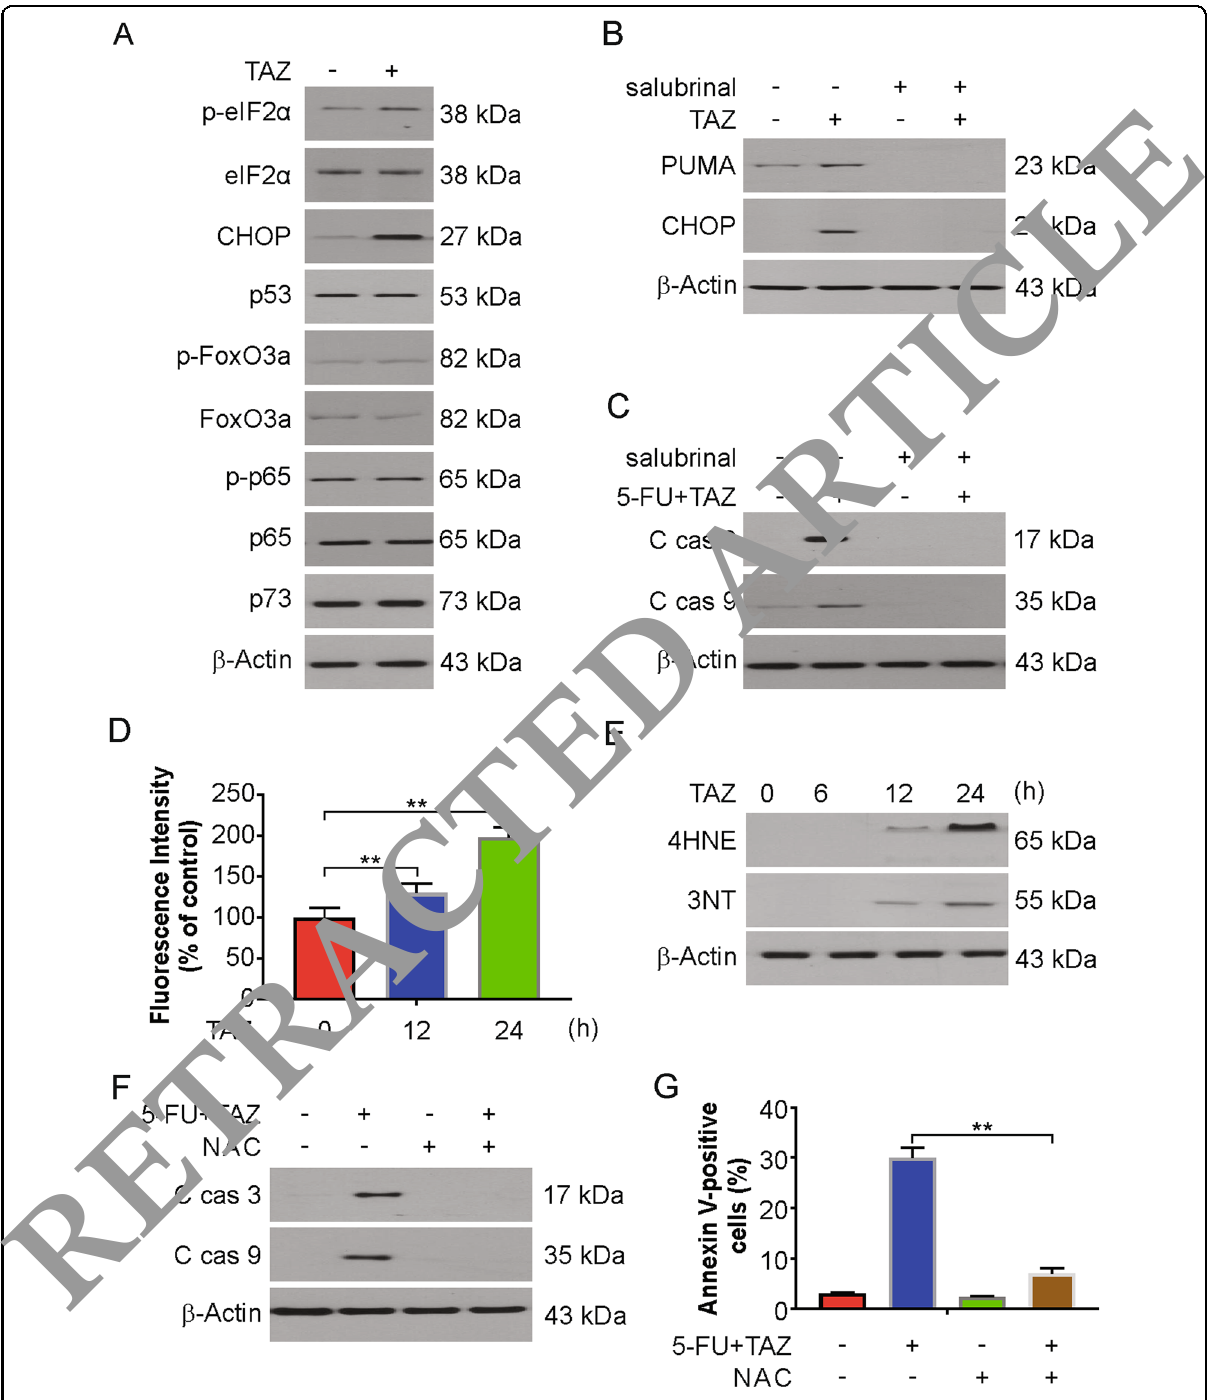
Fig. 4 Tazemetostat-induced PUMA via ROS/ER stress axis. A HCT116 cells were treated with 0.5 μ M tazemetostat for 24 h. Indicated proteins were analyzed by western blotting. B HCT116 cells were treated with 0.5 μ M tazemetostat, 1 μ M salubrinal or their combination for 24 h. Indicated proteins were analyzed by western blotting. C HCT116 cells were treated with the combination of 2.5 μ g/mL 5-FU and 0.5 μ M tazemetostat with or without salubrinal for 24 h. Indicated proteins were analyzed by western blotting. D HCT116 cells were treated with 0.5 μ M tazemetostat for 12 or 24 h. The expression levels of ROS were measured by DHE staining and analyzed by fl ow cytometry. E HCT116 cells were treated with 0.5 μ M tazemetostat for 24 h. Indicated proteins were analyzed by western blotting. F HCT116 cells were treated with the combination of 2.5 μ g/mL 5-FU and 0.5 μ M tazemetostat with or without NAC for 24 h. Indicated proteins were analyzed by western blotting. G HCT116 cells were treated with the combination of 2.5 μ g/mL 5-FU and 0.5 μ M tazemetostat with or without NAC for 24 h. Apoptosis was analyzed by fl ow cytometry. The results were expressed as the mean ± SD of three independent experiments. ** P <